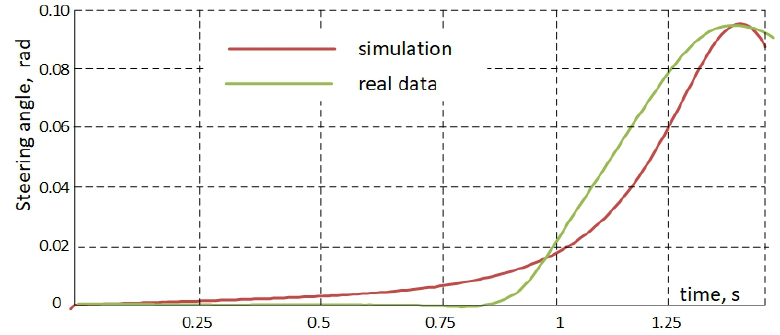
Figure 9. Progress of the steering wheel angle value.